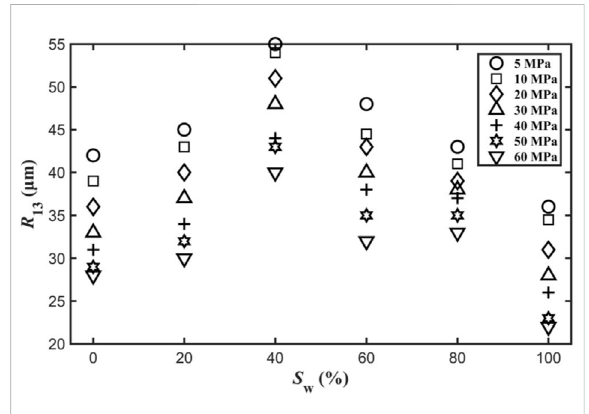
FIGURE 15 Radius of the gas pockets in the host skeleton R 13 as a function of water saturation, corresponding to sample 1 – 19 at different con fi ning